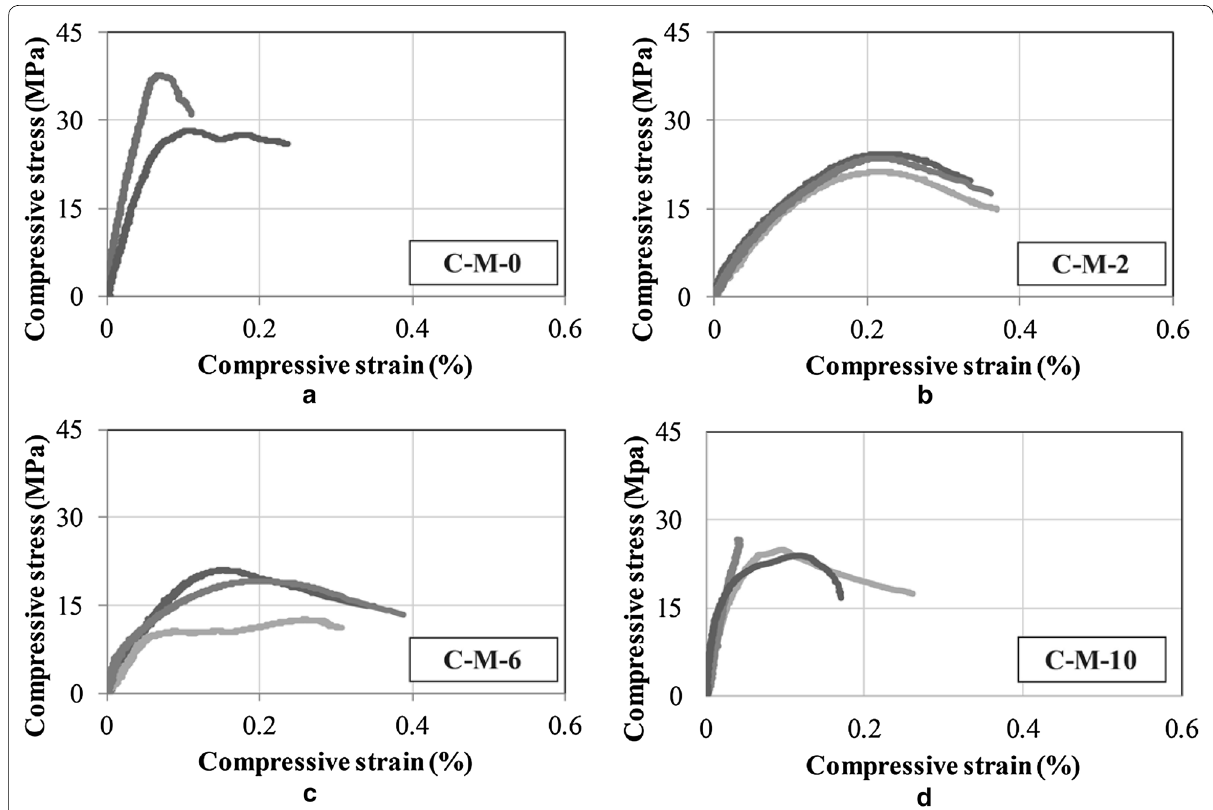
Fig. 14 Compressive stress–strain curves with M-level aggregates: a C-M-0, b C-M-2, c C-M-6, and d